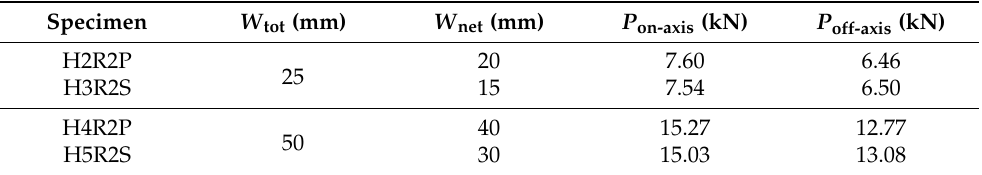
Table 6. Comparisons between ultimate loads of multiple-hole Glare with holes arranged in parallel and staggered forms (loads were achieved by 1/2 symmetric models in the thickness direction). Specimen W tot